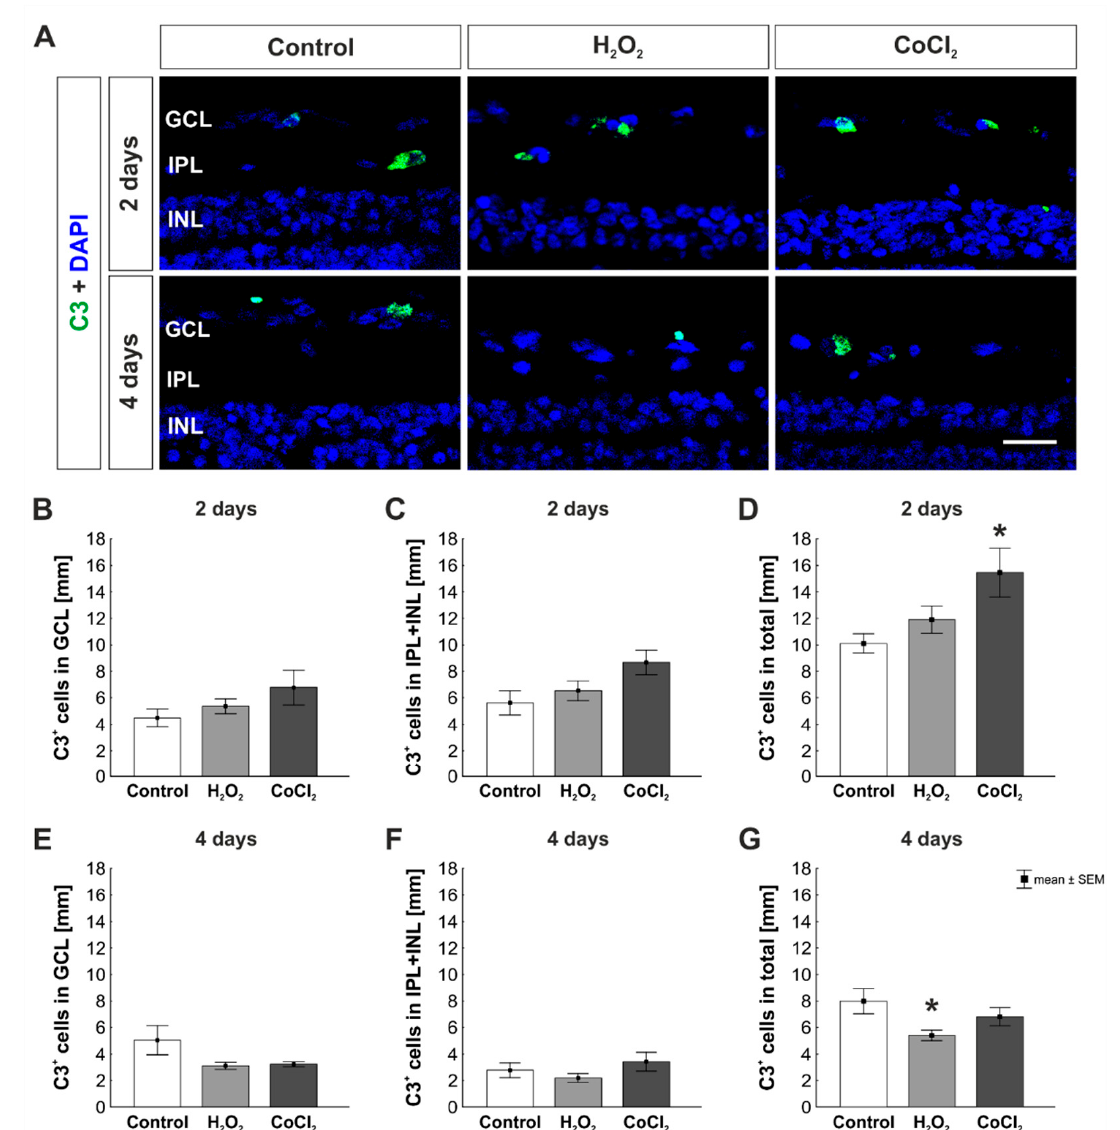
Figure 5. Early activation of the complement cascade in hypoxic retinas. ( A ) Cells were labeled with a C3 antibody (green) and cell nuclei with DAPI (blue). ( B ) The number of C3 + cells located in the GCL was comparable in all groups at two days. ( C ) The same was seen for C3 + cells located in the IPL and INL. ( D ) The total amount of C3 + cells in hypoxic retinas was significantly increased at two days ( p = 0.021). ( E ) At four days, the number of C3 + cells in the GCL was comparable in all groups. ( F ) Moreover, the C3 + cell count in the IPL and INL was not altered by H 2 O 2 or CoCl 2 . ( G ) Interestingly, in the total retina, there were significantly fewer C3 + cells in oxidative stressed retinas ( p = 0.046). GCL = ganglion cell layer; IPL = inner plexiform layer; INL = inner nuclear layer. N = 8. Scale bar: 20 µ m. Values are shown as mean ± SEM. Columns marked with * show significant differences in comparison to the control group. * p <